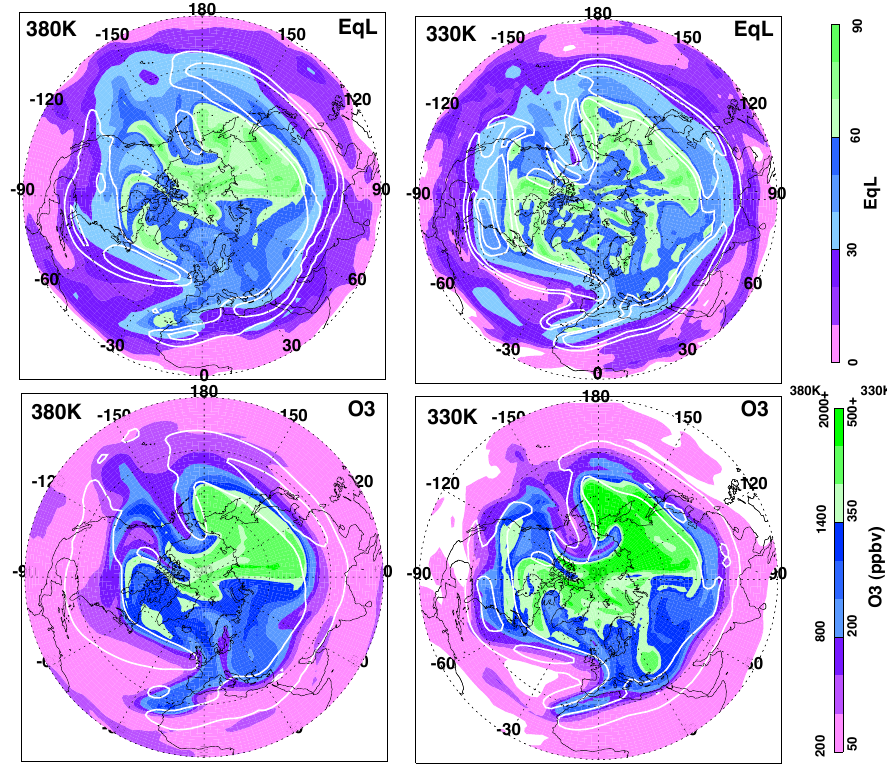
Fig. 7. WACCM EqLat and O 3 on the 380K (left column) and 330K (right column) θ -surfaces for 15 February 2006. The position of the jet is represented by white contours (wind speeds of 30 and 40ms − 1